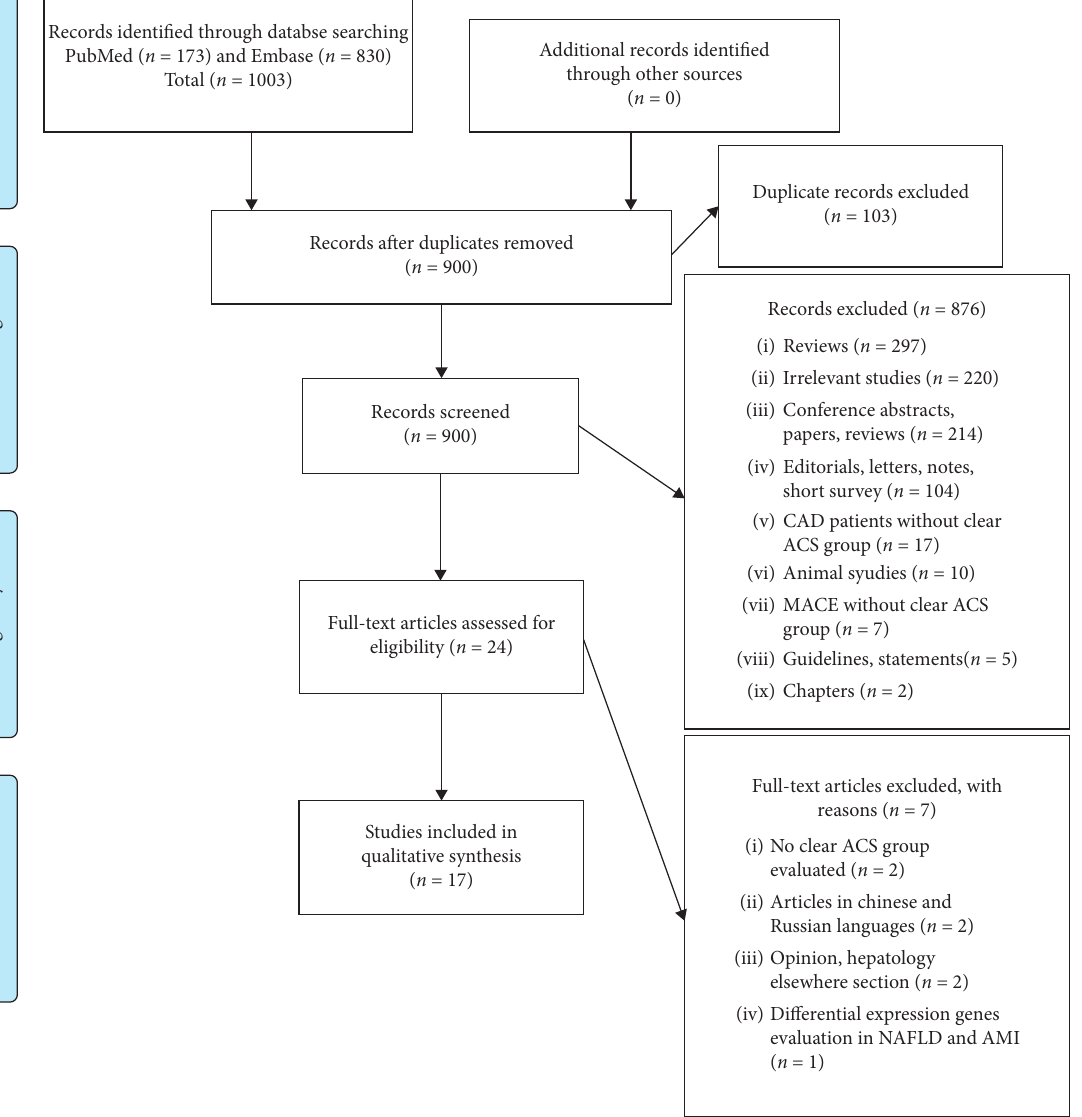
Figure 1: PRISMA flow diagram for search and selection processes of this systematic